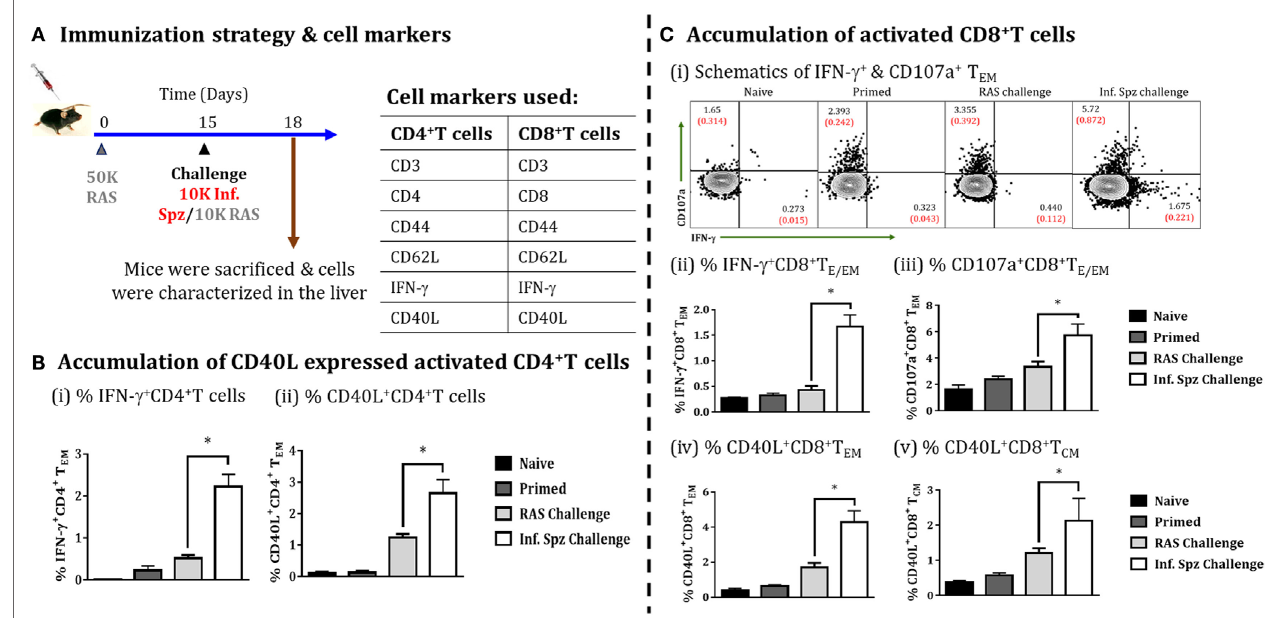
FigUre 7 | Accumulation of activated CD4 + T cells and CD8 + T cells in the liver on challenging the immunized mice, (a) immunization strategy and cell markers used to characterize CD4 and CD8 T cells. Mice were primed with 50K radiation-attenuated sporozoites (RAS), on day 15 one group of mice were challenged with 10K Inf. Spz and another group with 10K RAS. Mice were sacrificed 72 h post-challenge, (B) accumulation of activated CD4 + T cells in liver, (i) % IFN- γ -producing CD4 + T E/EM cells, (ii) % CD40L expressed CD4 + T E/EM cells. (c) Accumulation of activated CD8 + T cells, (i) schematics of IFN- γ + and CD107a + CD8 + T E/EM cells, (ii) % IFN- γ -producing CD8 + T E/EM cells, (iii) % CD107a expressed CD8 + T E/EM cells, (iv) % CD40L expressed CD8 + T E/EM , (v) % CD40L expressed CD8 + T CM . Each bar shown in graph is mean of four individual mice per group. Percent cell shown is the percent out of total mononuclear cells or lymphocytes. N = 4 mice per group. Data are the mean ± SEM. The data were analyzed with non-parametric Mann–Whitney U -test. p < 0.05 is considered as a significant. Data shown represent one of two independent